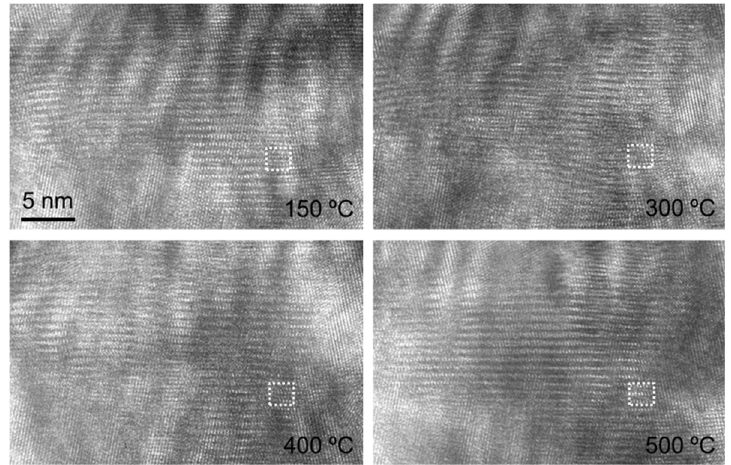
Figure 15. HRTEM images of the same region in TGO at different temperatures.